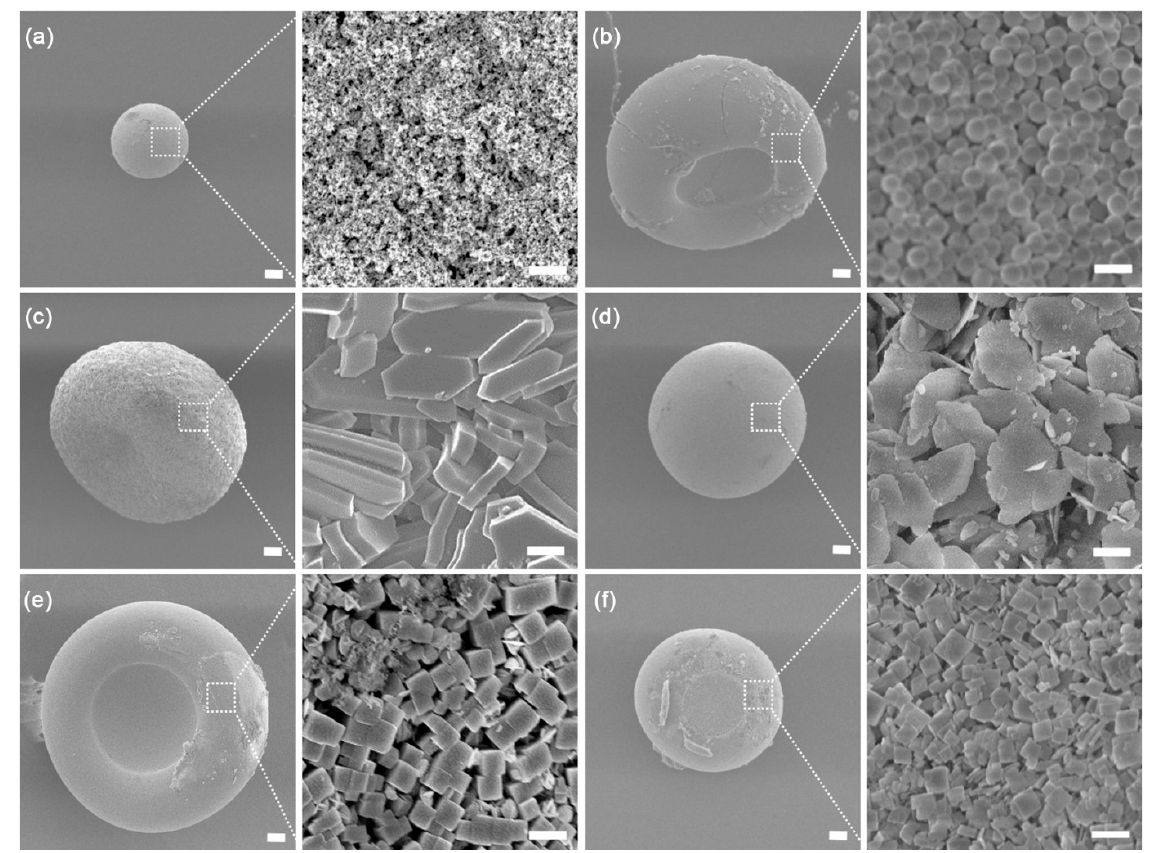
Figure 5. SEM images of supraparticles. Supraparticles fabricated by ( a ) aggregates of NPs, ( b ) spherical NPs, and ( c ) coffin-shaped NPs, ( d ) nanosheets, ( e ) nanocubics, ( f ) nanoplates. The scale bars are 100 μ m for the left image and 1 μ m for the magnified images at the right of each figure.